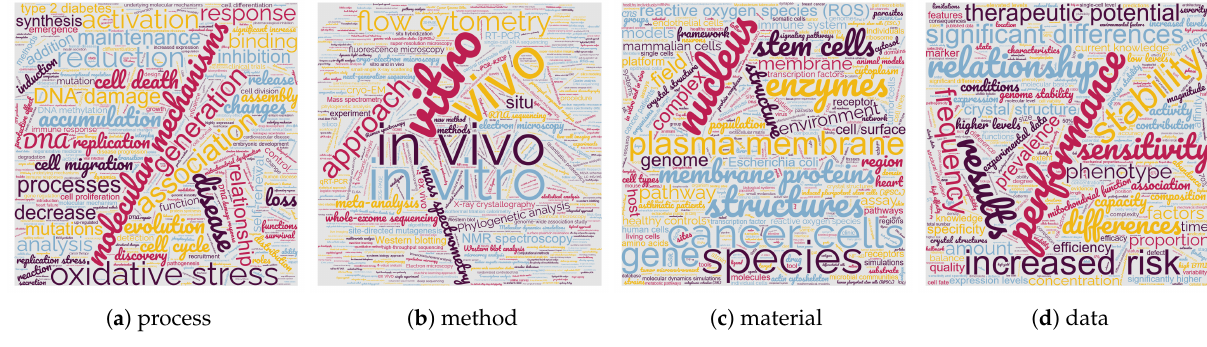
Figure 3. Biology domain word clouds.